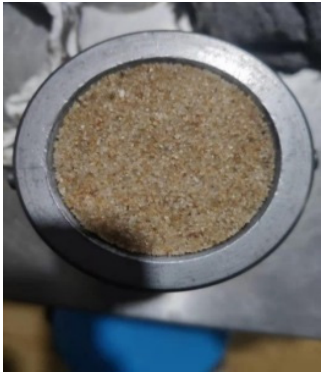
Figure 8. Fabricated sand specimen.